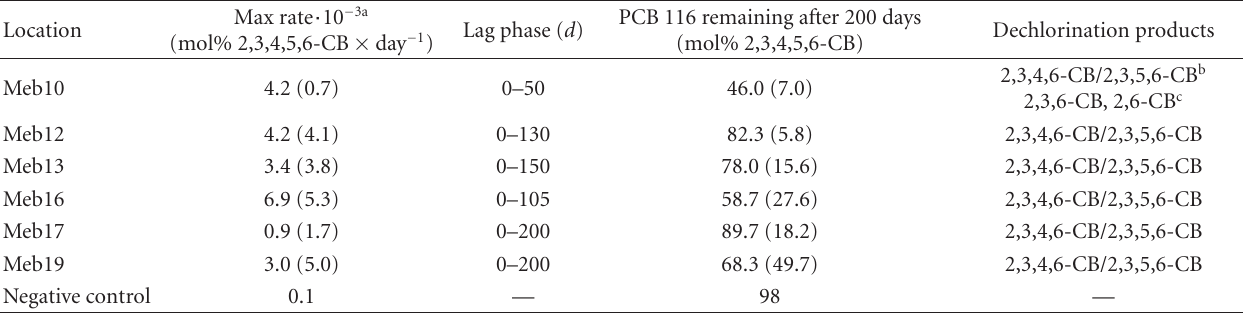
Table 3: The potential dechlorination activity of the soil samples in microcosms. Locations not listed here did not show any dechlorination activity.